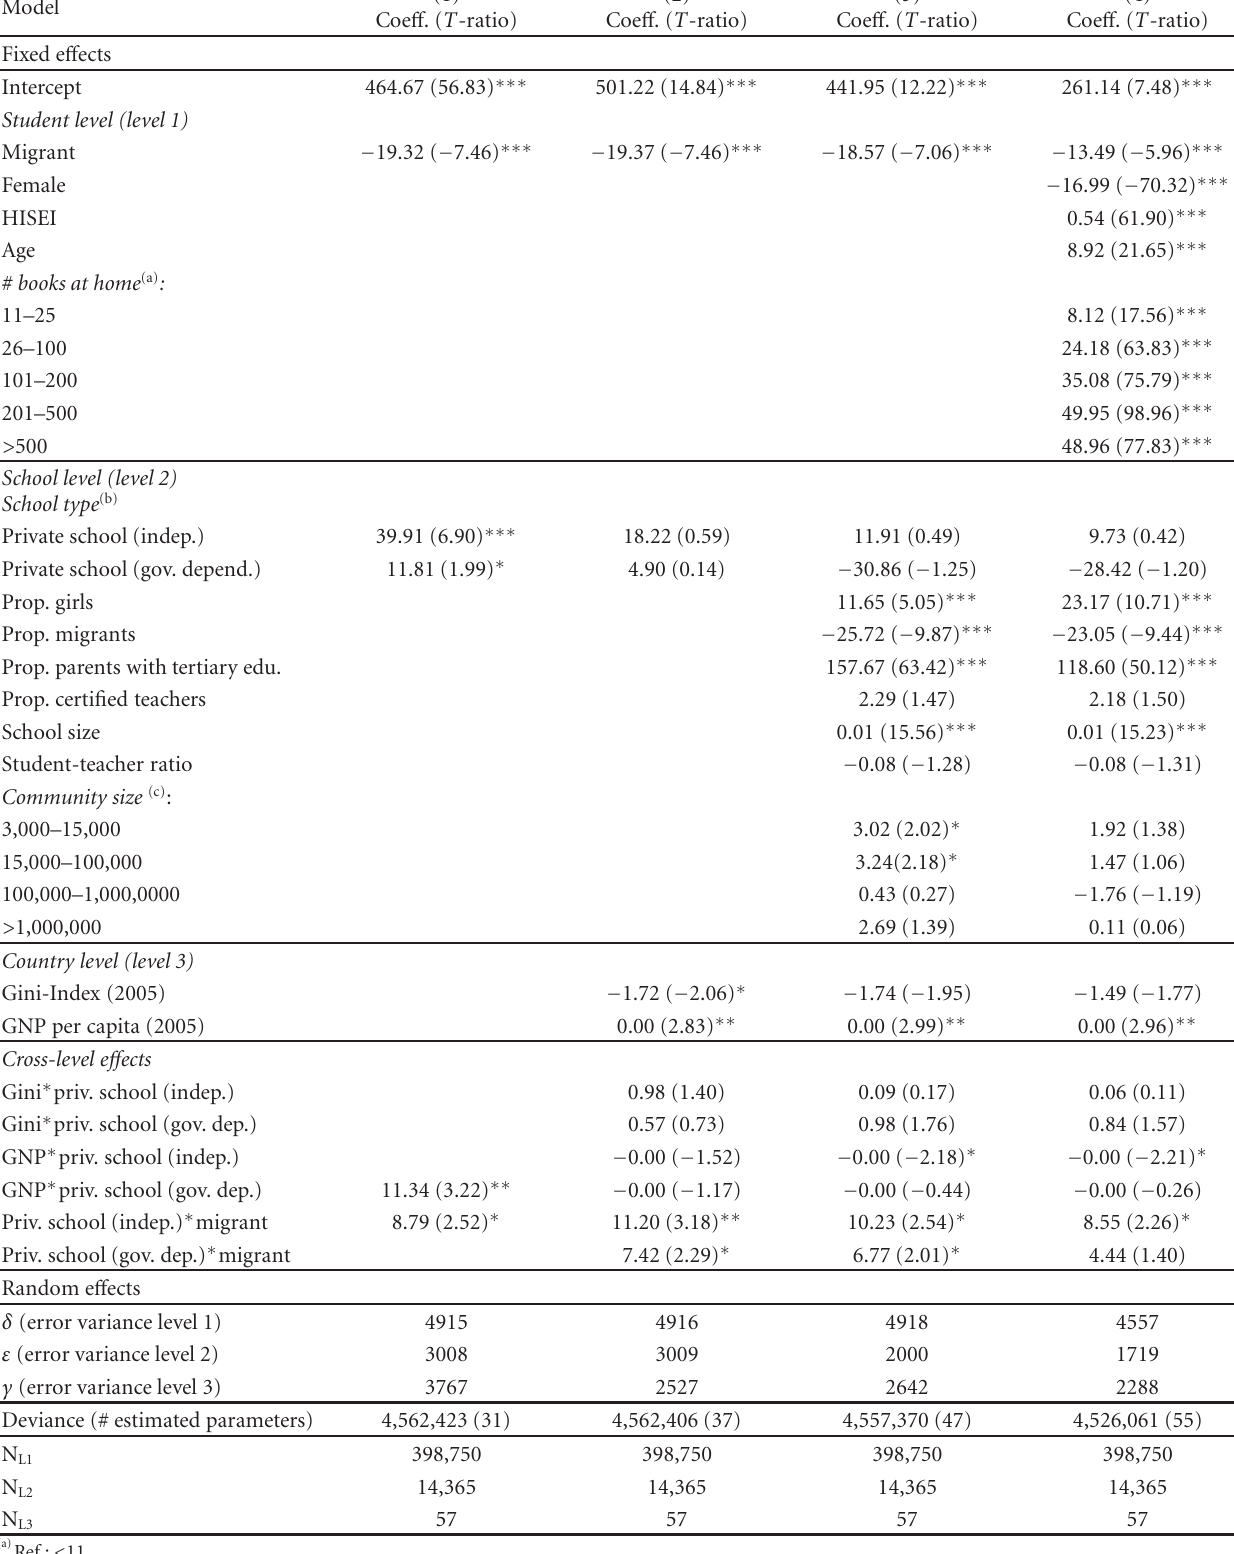
Table 6: Hierarchical multilevel models: determinants of mathematics